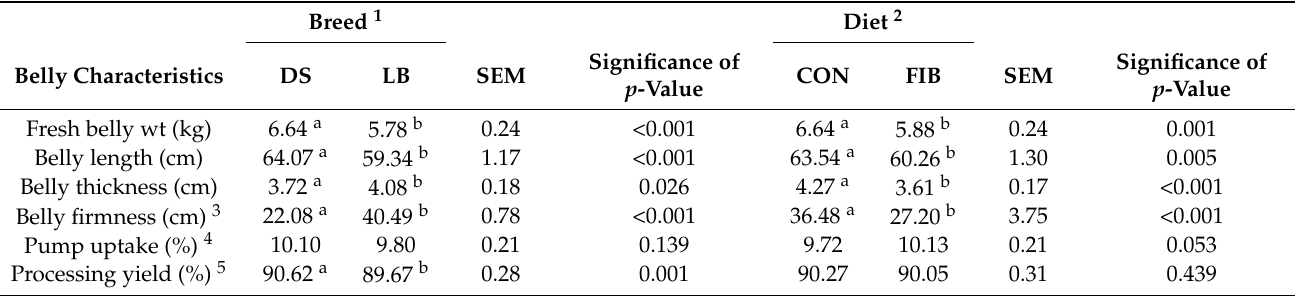
Table 1. Effect of breed and diet on fresh belly characteristics.